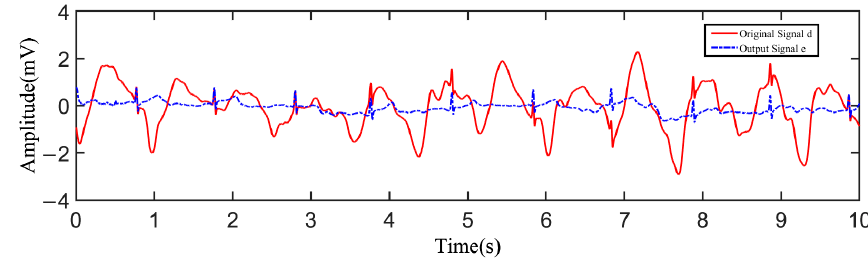
Figure 11. The contrast between the output signal and the original signal.